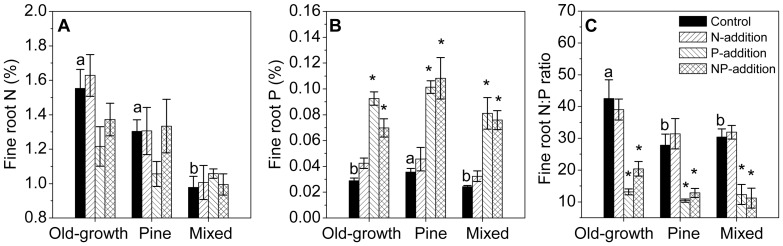
Nutrient concentration in live fine roots after five years of nitrogen and phosphorus additions.Data from July 2012. Different letters indicate significant differences among forests (P<0.05). * indicates significant differences between each treatment and control (P<0.05). Error bars show SE (n = 5).